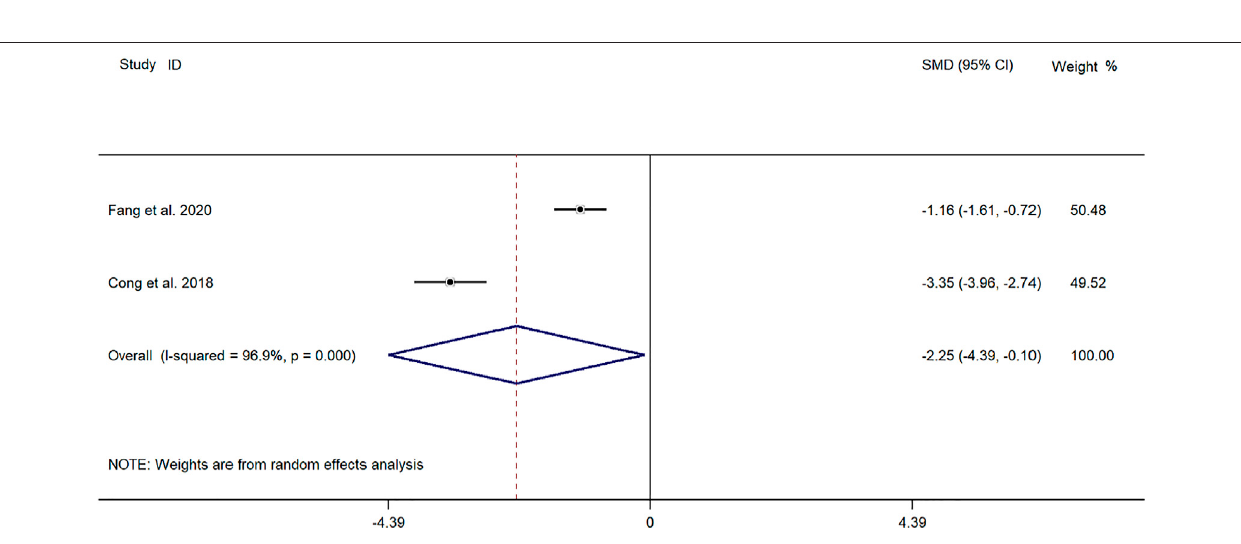
Frontiers in Pharmacology |